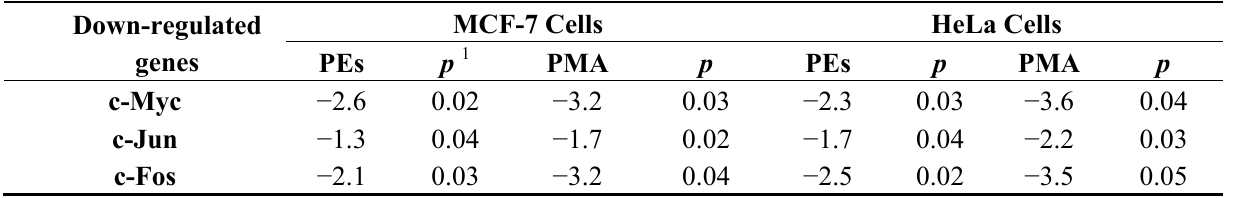
Table 3. Fold-changes in the expression levels of c-Myc, c-Jun and c-Fos genes in MCF-7 and HeLa cell lines upon treatment with PEs and